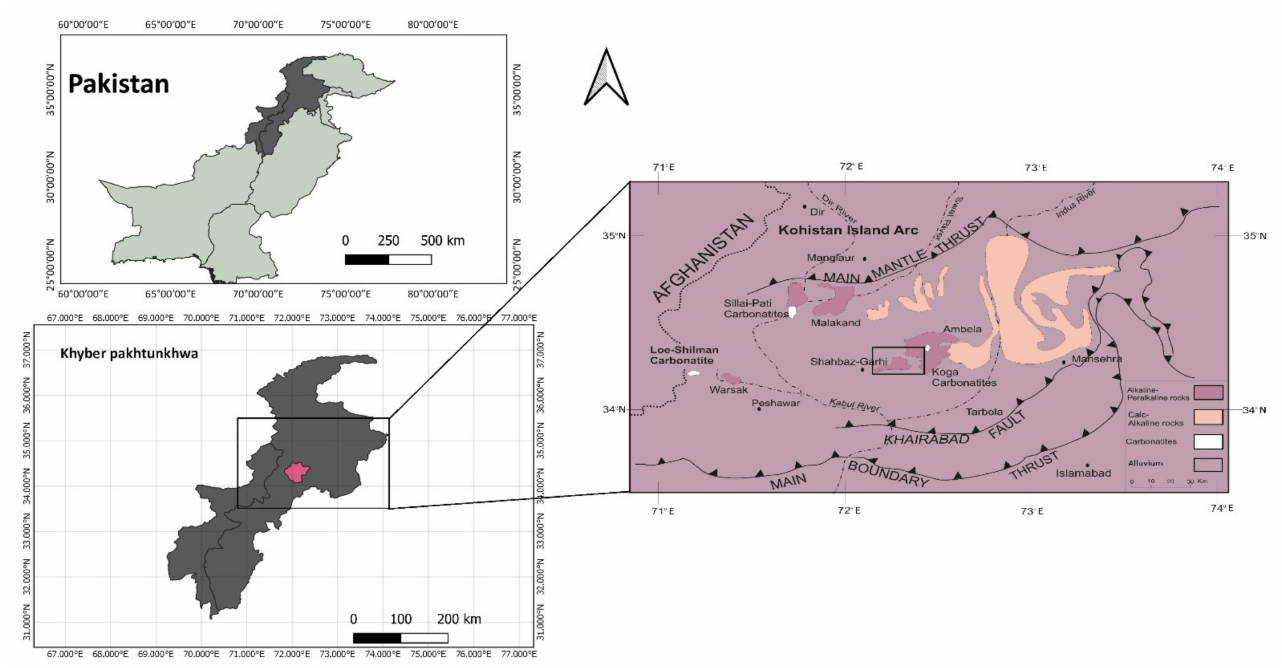
Figure 1. Location map of the study area in Pakistan with the region of interest